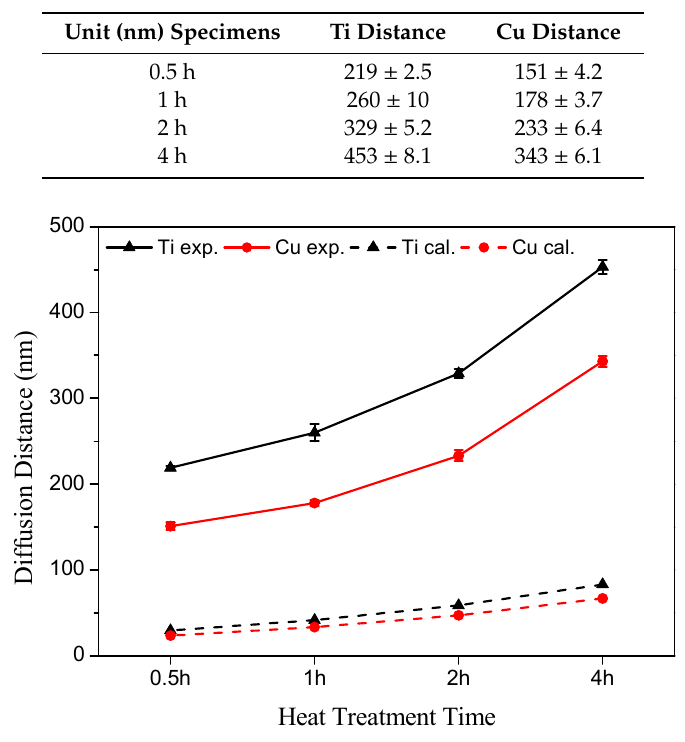
Figure 2. Experimental and theoretical values of diffusion distance.